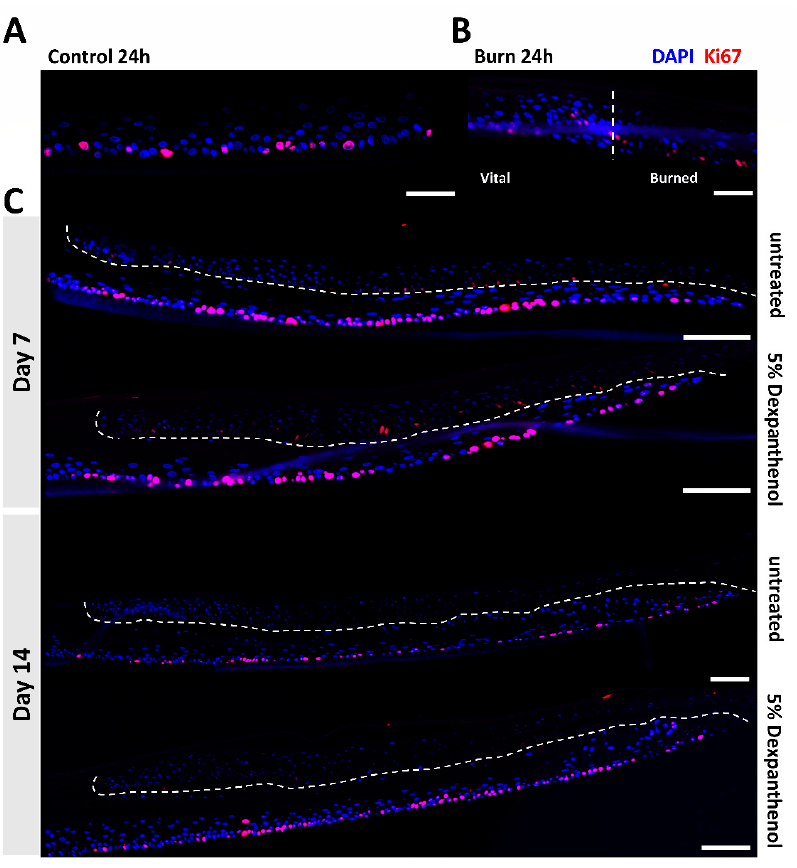
Figure 5. Immunofluorescence of the OS-REp models showing the living cells through anti-Ki67 staining. ( A ) Antigen Ki67 (Ki67) staining the control OS-REp model; scale bar: 50 µ m. ( B ) Merged image of both DAPI and Ki67 staining highlighting the wound edge (dotted line); scale bar: 50 µ m. ( C ) Merged images of day 7 and 14 of the OS-REp models treated with 5% dexpanthenol or without treatment. The images indicate the development of a new epidermal tissue under the old damaged tissue; dotted lines indicate the separation of both tissues; scale bar: 100 µ m.